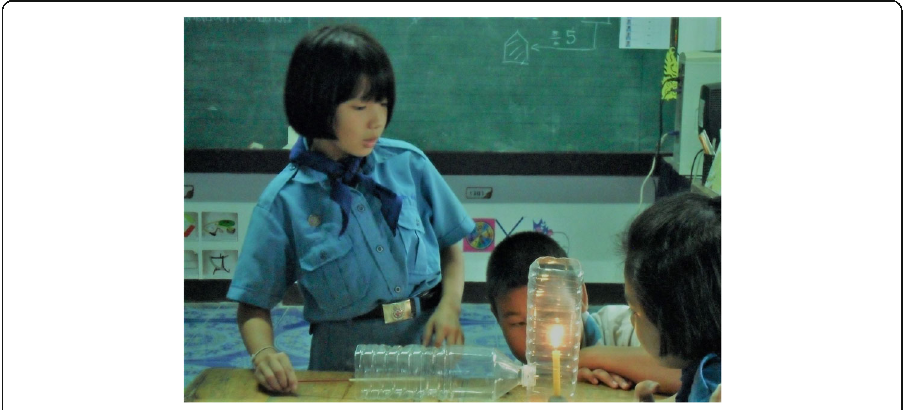
Fig. 2 The experimentation of air movement. The students were observing and explaining about the direction of air